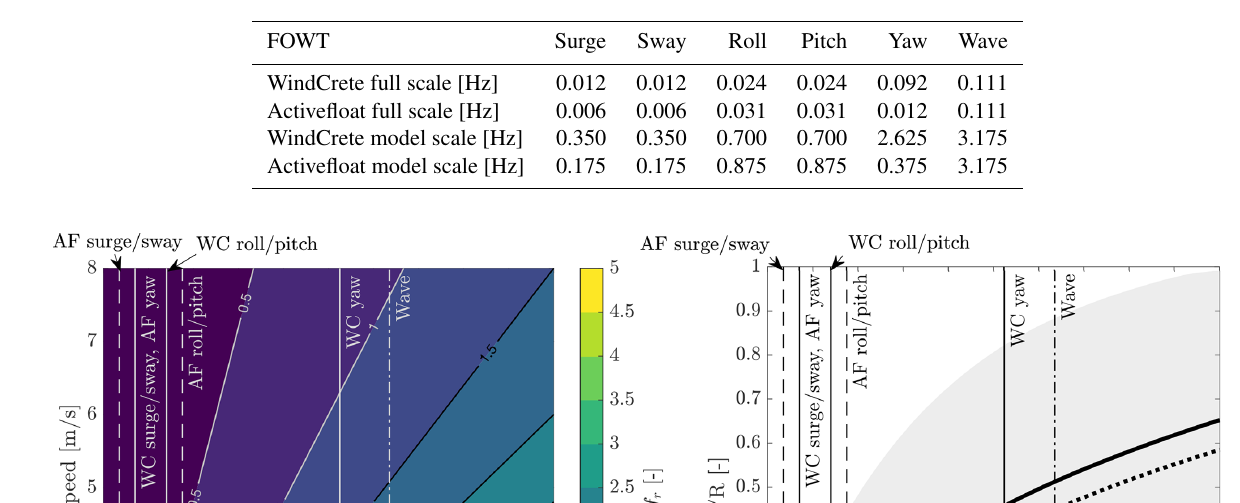
Table 3. Full-scale and model-scale values of the natural frequencies and wave frequency for the Activefloat and WindCrete. Full-scale values are taken from Mahfouz et al. (2021).